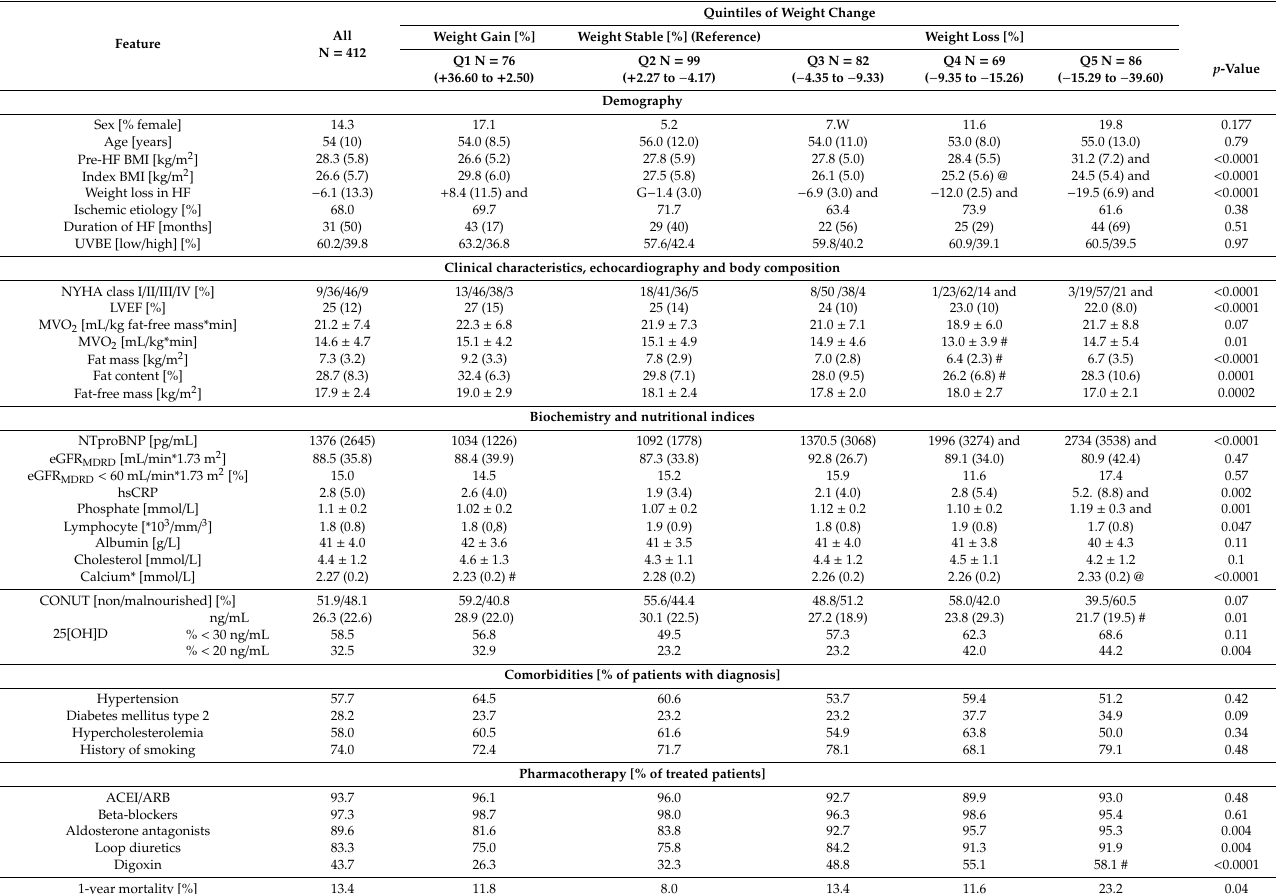
Table 1. Clinical and laboratory characteristics of study group. Comparison between subgroups of weight changes